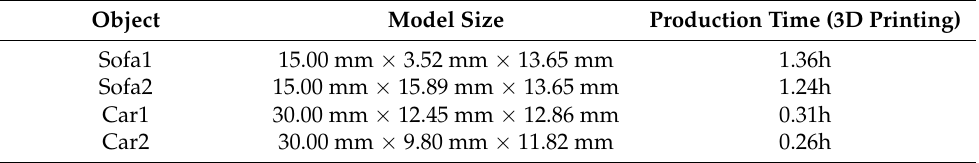
Table 4. Object print parameter settings.